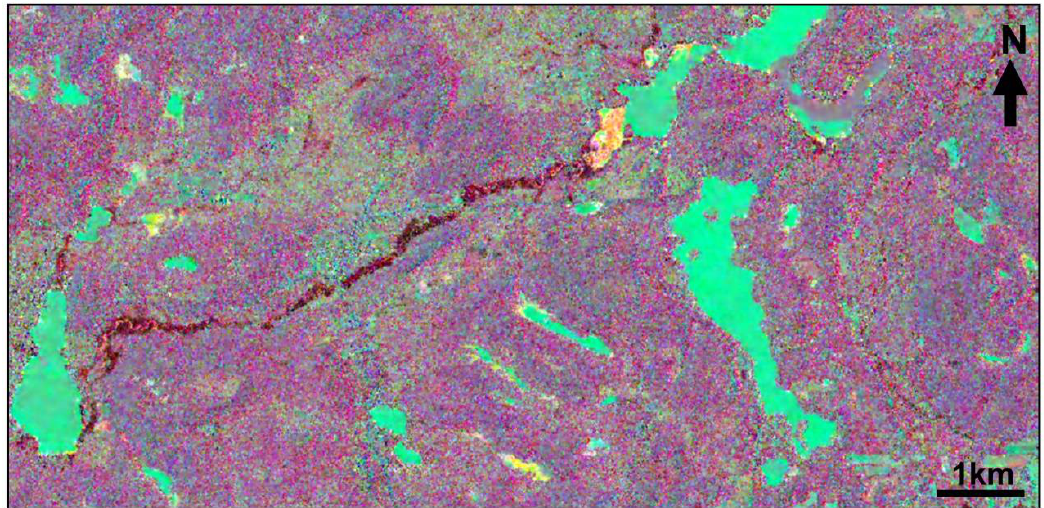
Figure 11. False colour composite of the differential Kennaugh elements, K 0 -K 3 -K 4 , differenced between the 18 June 2016 scene and the 2 April 2016 scene. Red represents the change from flooded vegetation to land. Green represents the change from ice to open water. Yellow represents the change from open water to marshland.